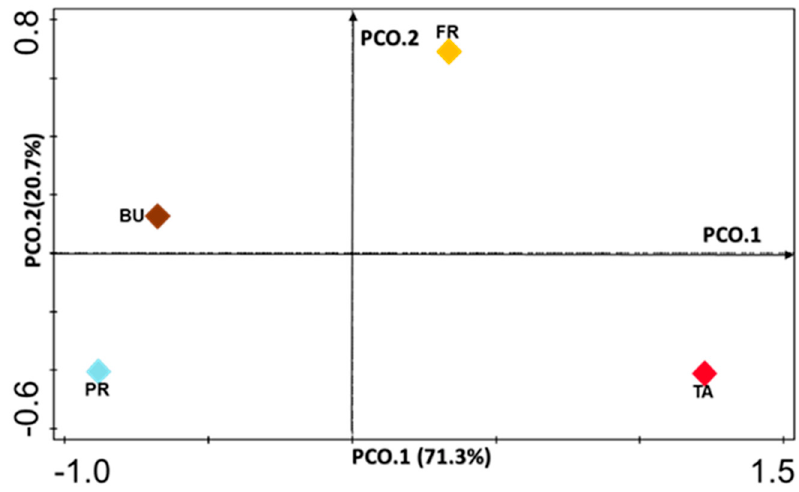
Figure 5. Principal coordinate analysis (PCoA) of nitrifying bacteria and archaea genera across different growth stages.